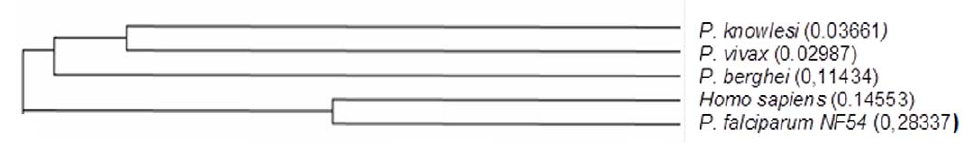
Figure 3. Multiple amino acid alignment of DOHH from P. vivax to three different Plasmodium species ( Plasmodium knowlesi , Plasmodiumberghei and Plasmodiumfalciparum ). Human DOHH and DOHH from P. vivax were also included in the alignment. EZ-HEAT repeats are numbered in their sequential order and are coloured in pink. Significant is the amino acid identity of blue coloured amino acids in EZ-HEAT repeat number 1 (amino acid position 68–96) and EZ-HEAT repeat number 2 (amino acid position 103–134) to EF-type phycocyanin lyase from cyanobacteria [38].The other two different EZ-HEAT repeats exhibit various degrees of identity to enzymes involved in energy metabolism (significant amino acids are marked in blue letters). The highly conserved histidine glutamate residues are marked in red. The secondary structure prediction is given above the alignment. The secondary structure is presented on top of the alignment and was determined by the JPred vers. 3.0 and Scratch programmes [39]. H represents the a -helix, E means an extended structure, T means a b -turn, and C symbolizes the remainder. Gaps (.) were introduced to obtain maximal alignment. Asterisks label amino acid identities, colons (:) and dots (.) label amino acid similarities.